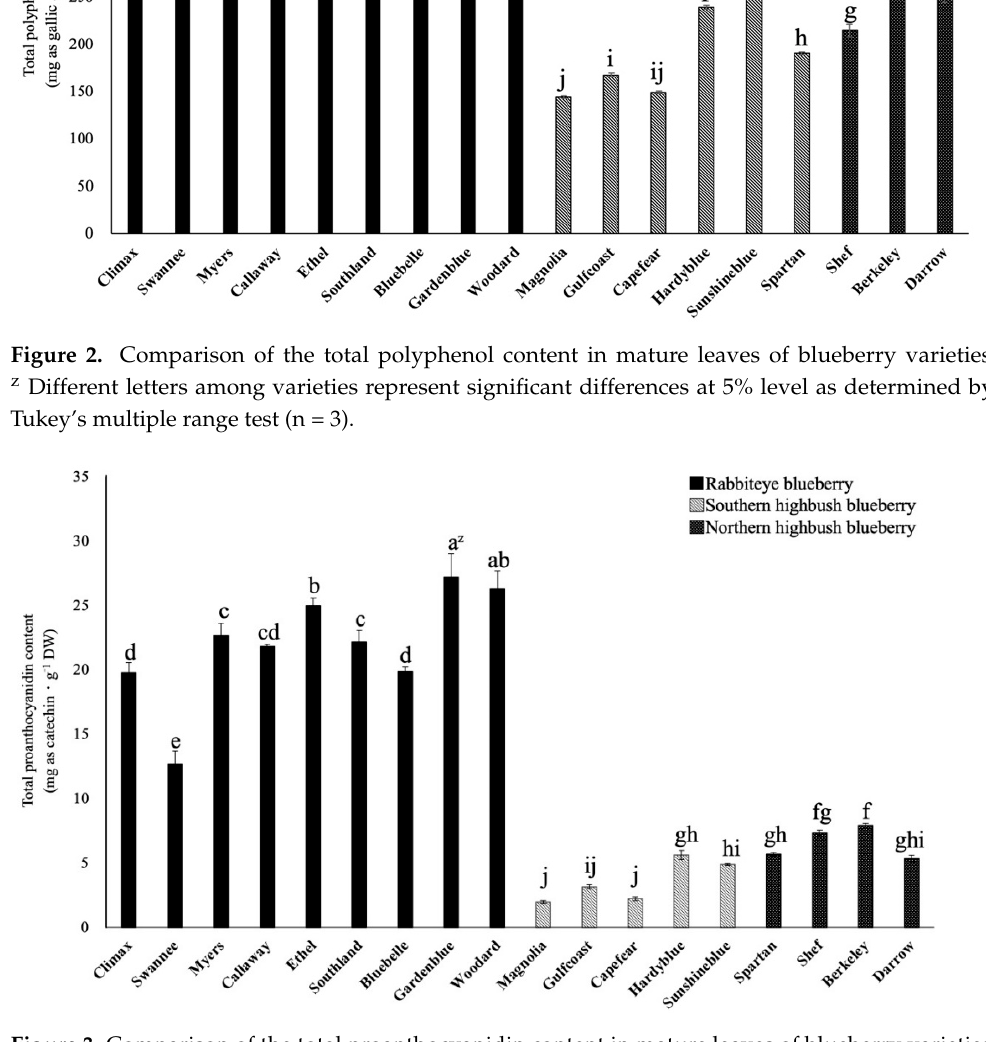
Figure 2. Comparison of the total polyphenol content in mature leaves of blueberry varieties. z Dif- ferent letters among varieties represent significant differences at 5% level as determined by Tukey’s multiple range test (n = 3).